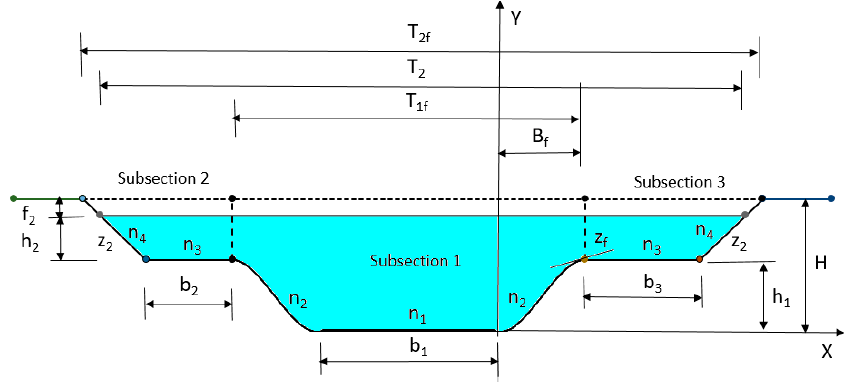
Figure 2. Proposed compound section with polynomial sides for main channel.